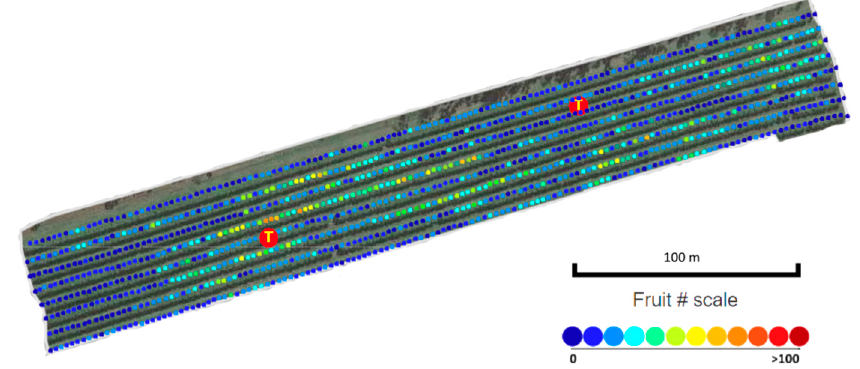
Figure 9. Fruit load ‘heat map’ for a farm affected by frost at flowering (top panel), and of early fruit in an orchard (bottom panel). Red ‘T’ denotes location of temperature sensors. Red ovals indicate area of influence of frost fan (top panel).